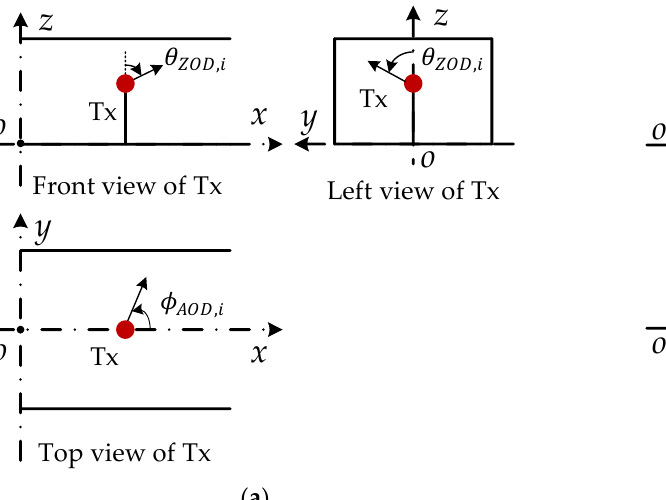
Figure 2. Three views of T2T communication scenario: ( a ) transmitter, ( b ) receiver.